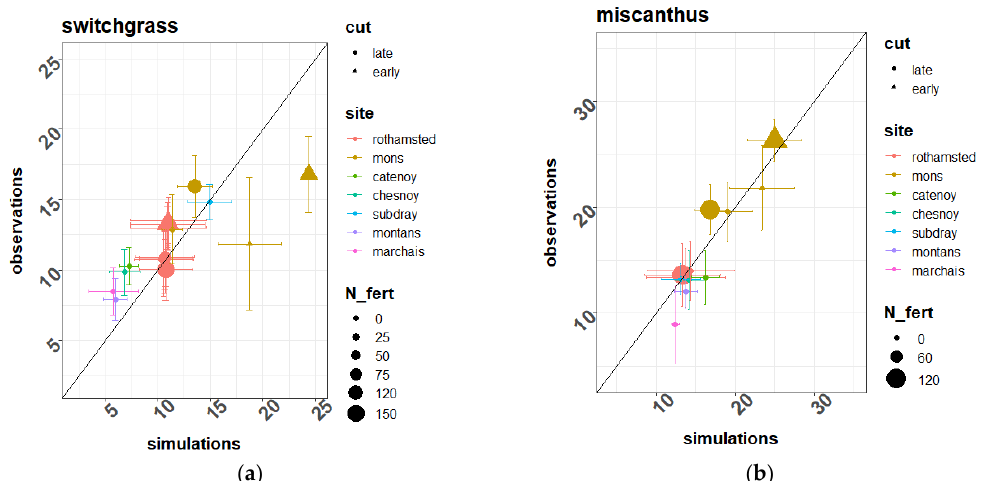
Figure 5. Simulated vs. observed yields for the ( a ) switchgrass and ( b ) miscanthus crops across the 7 experimental sites and management treatments. Symbols represent the average yields over the lifespan of the crops, and are coded according to the location and management treatments of these experiments. The error bars represent the standard deviations of the same series of simulated and observed yields for each site-treatment combination. Key to variables: cut—harvest time (late or early); N_fert—Fertiliser N input rate (kg N ha −1 yr −1 ). across the various sites and treatments, with mean deviations under 1% of the average yields, and global RMSEs of 4.7 t DM ha −1 for miscanthus and 4 t DM ha −1 for switchgrass. This translates as relative RMSEs of 31% and 33%, respectively (Table 4).